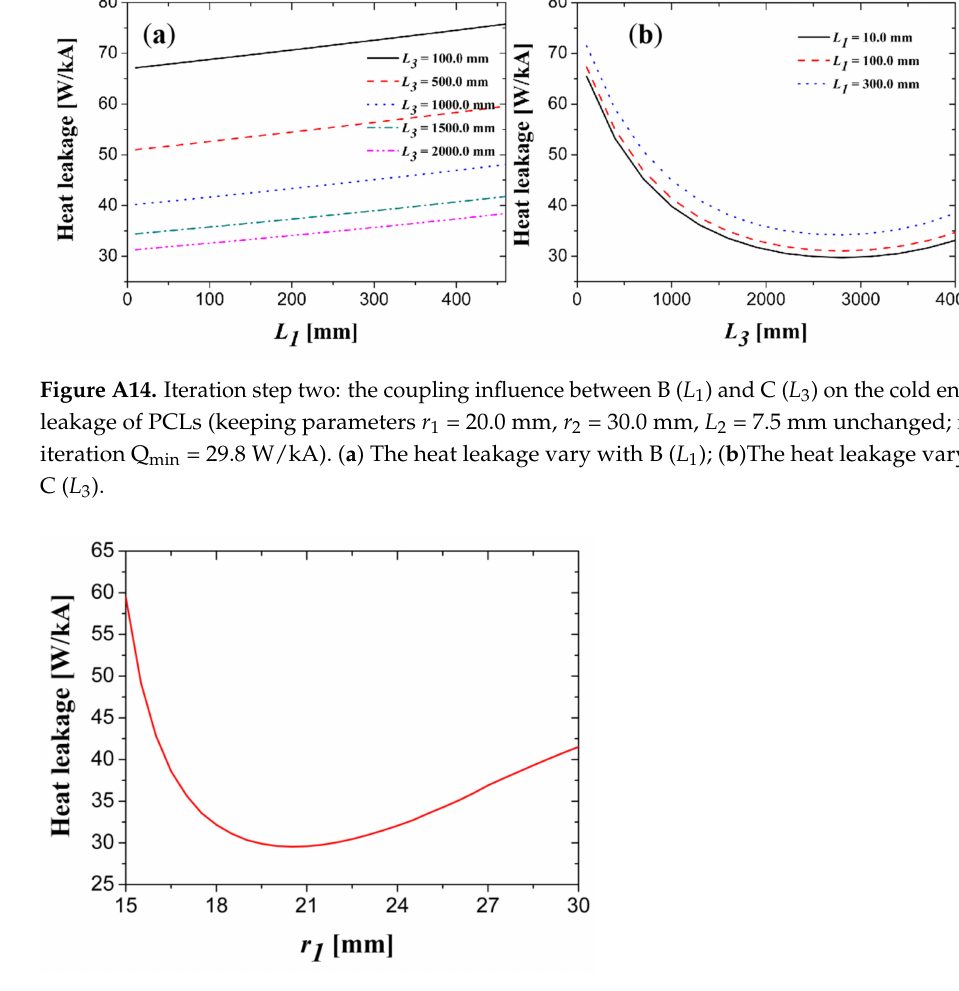
Figure A15. Iteration step three: the effect of radius of the copper leads r 1 on the cold end heat leakage of PCLs (keeping parameters L 1 = 10.0 mm, L 3 = 2900.0 mm, r 2 = 30.0 mm, L 2 = 7.5 mm unchanged; in this iteration Q min = 29.8